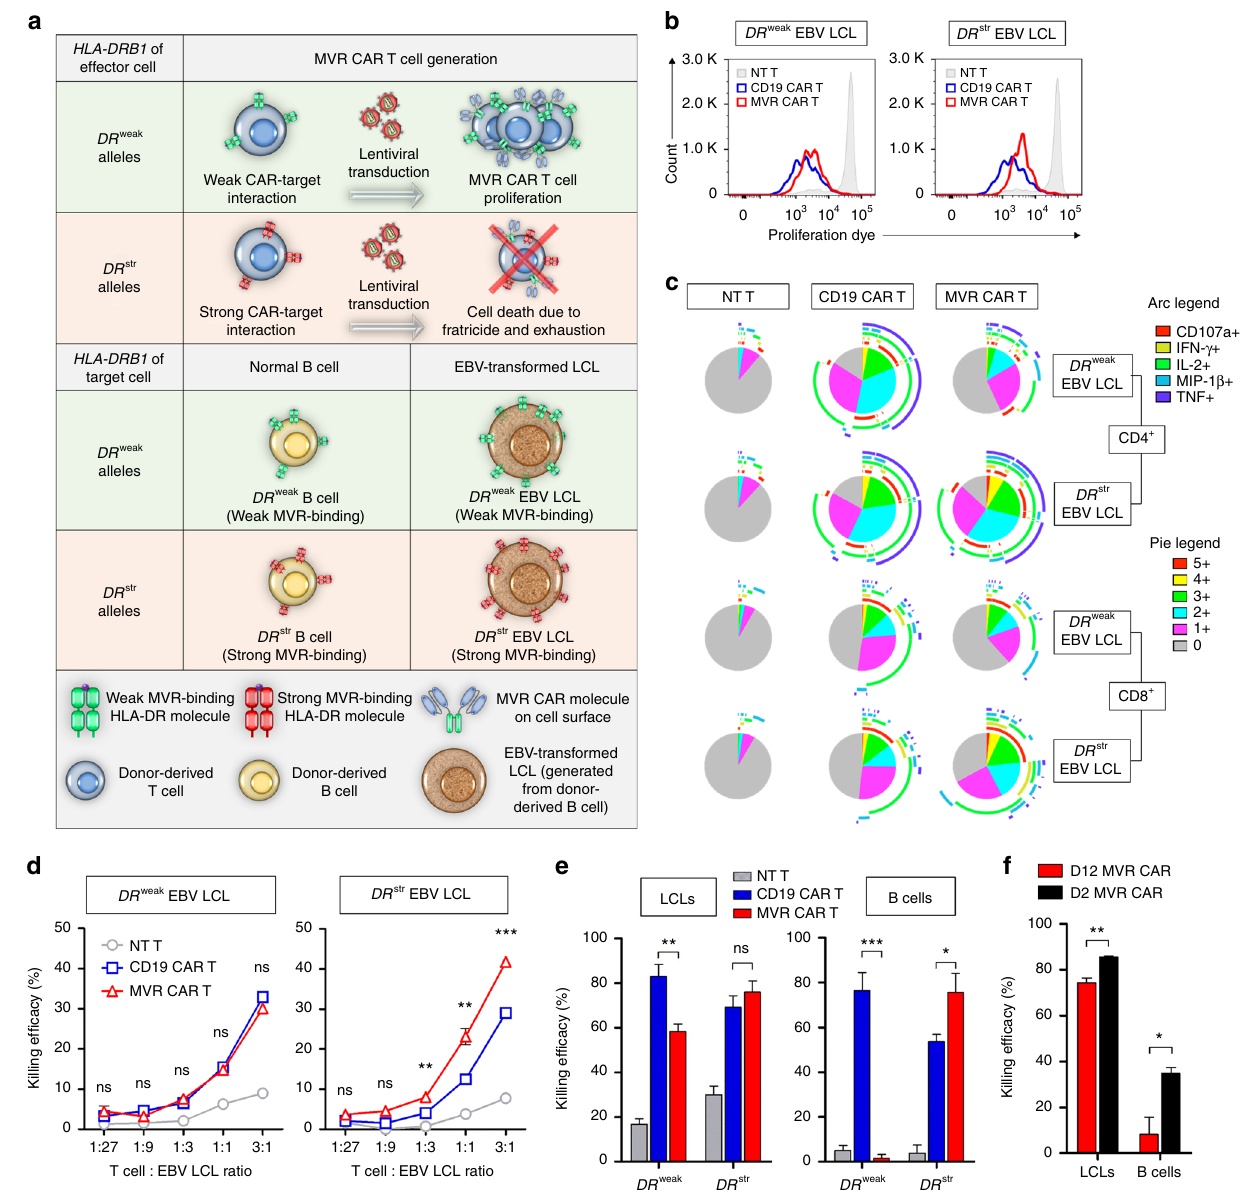
Fig. 3 MVR CAR T cells have speci fi c killing activity against EBV LCLs. Cells from donors with different HLA-DRB1 alleles exhibiting strong or weak binding with MVR ( DR str or DR weak , respectively; Fig. 1a) were used in the following experiments. a Illustrative summary of MVR CAR T cells and target cells used in this study. b Proliferation of T cells measured after activation by DR weak EBV LCLs or DR str EBV LCLs. c Expression of multiple functional markers measured in non-transduced (NT) T, CD19 CAR T, and DR weak MVR CAR T cells after contact with DR weak or DR str EBV LCLs. The length of the arc of each color indicates the frequency of expression of the corresponding marker. The area of the pie of each color indicates the frequency of cells expressing the given number of functional markers. Pie charts were drawn based on the data measured in Supplementary Fig. 4b using a SPICE v5.0 (NIAID). d Killing ef fi cacy of NT T, CD19 CAR T, and DR weak MVR CAR T cells against DR weak or DR str EBV LCLs assessed in cytotoxicity assays. e Target-speci fi c killing by each CAR T cell type evaluated with an in vitro on-target killing assay. EBV LCLs and peripheral blood mononuclear cells carrying either DR weak or DR str HLA-DRB1 alleles were co-incubated with NT T, CD19 CAR T, or DR weak MVR CAR T cells. After incubation, the number of viable cells was determined and the killing ef fi cacy was calculated as indicated in Supplementary Fig. 5a. f Target-speci fi c killing of DR weak MVR CAR T cells on day 2 or 12 post- transduction (D2 or D12, respectively). DR weak EBV LCLs were co-incubated with D2 or D12 MVR CAR T cells. After incubation, the number of viable cells was determined and killing ef fi cacy was calculated as indicated in Supplementary Fig. 5b. b , c , e Representative of three independent experiments. d , f Representative of two independent experiments. d – f n = 3 biological replicates. Mean ± s.e.m. Unpaired two-tailed t -test: ns not signi fi cant; * p < 0.05; ** p < 0.01; *** p <